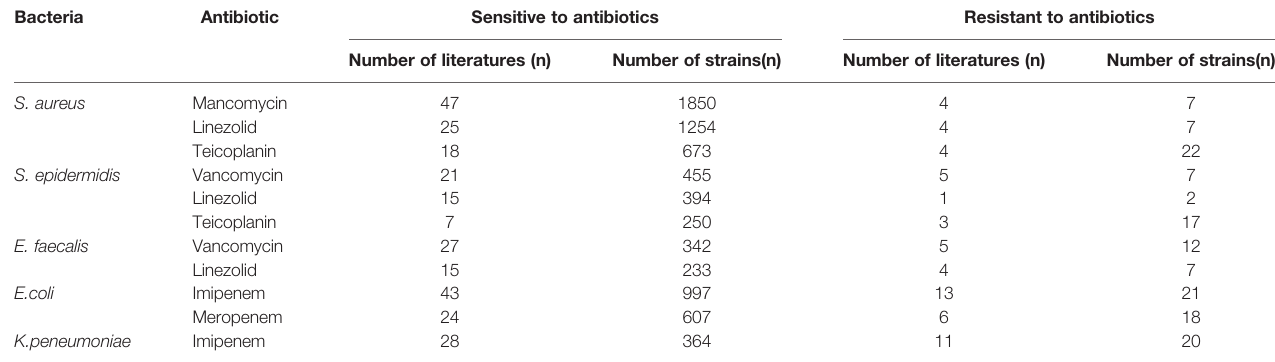
TABLE 4 | Resistance analysis of common bacteria to sensitive antibiotics.